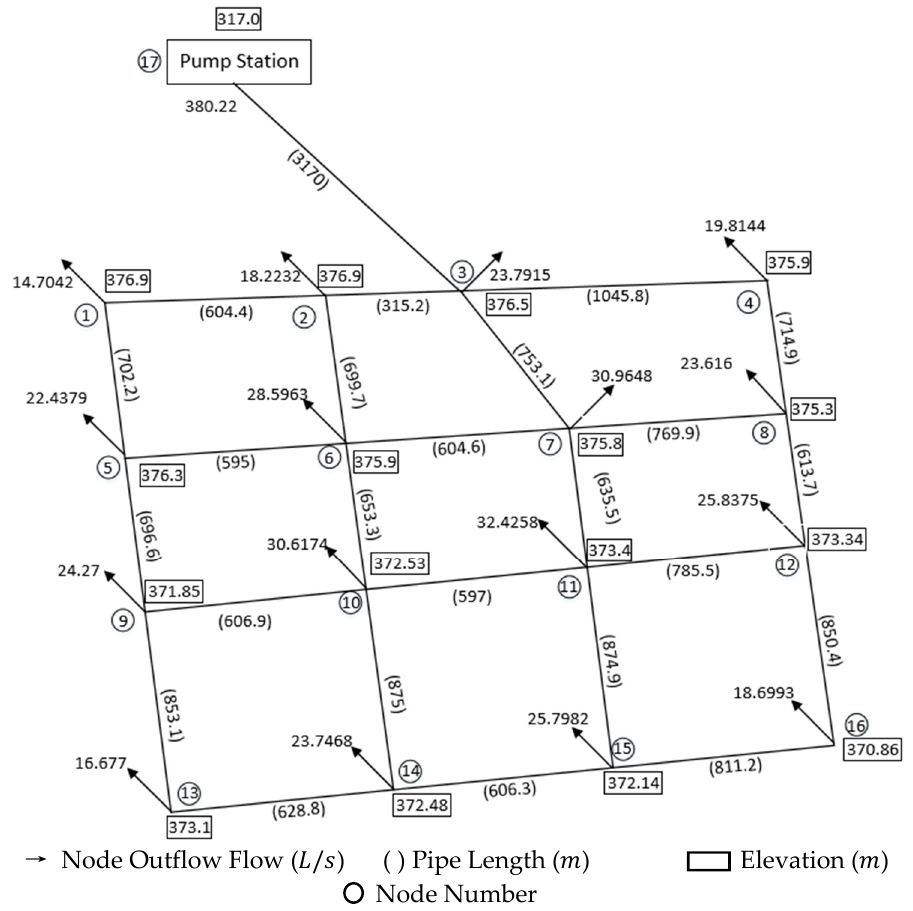
Figure 5. Water distribution network layout of the single pump station project.